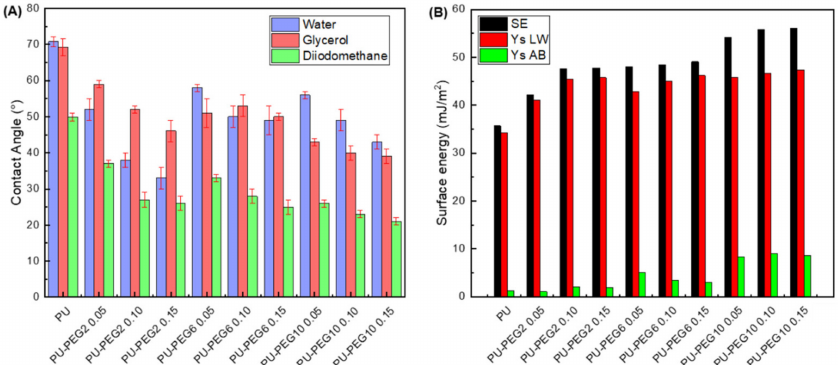
Figure 5. ( A ): Contact angles of the unmodified and PEG-grafted PU substrata with water, glycerol, and diiodomethane; ( B ): surface free energy of the substrata obtained with van Oss and Good model. SE: surface energy; Ys LW: dispersive component; Ys AB: polar